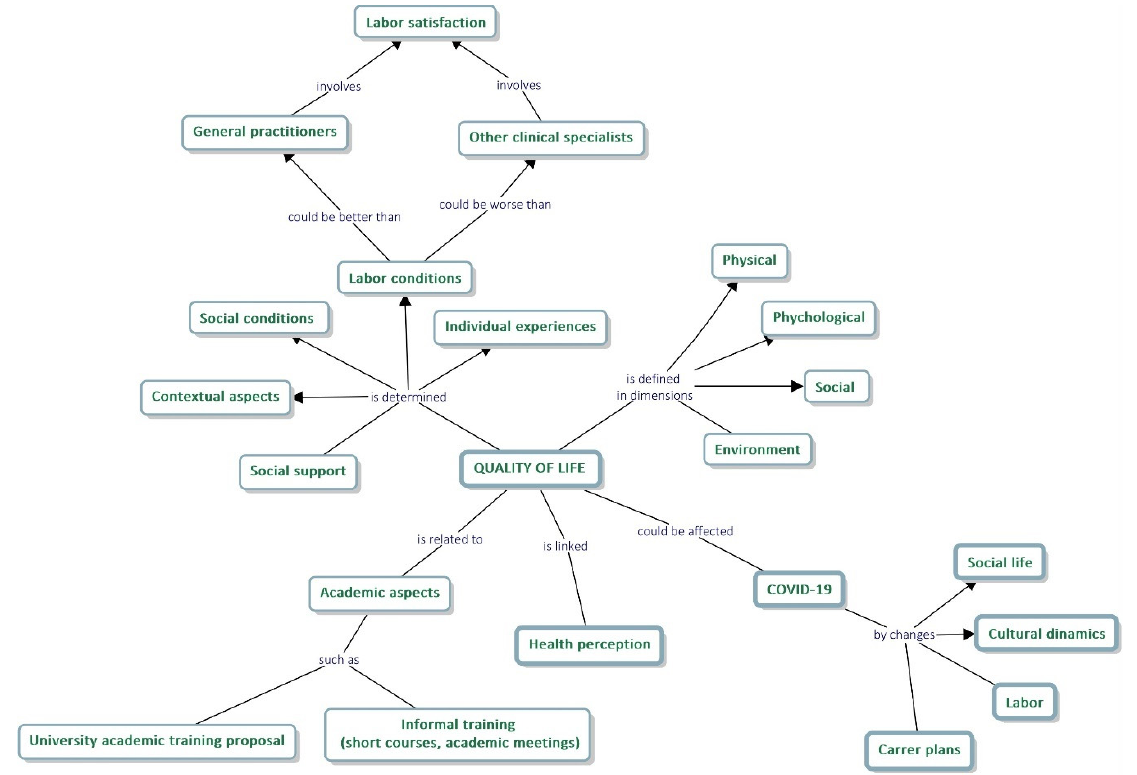
Figure 2. A conceptual explanatory map for understating the factors influencing QOL in the study population. Medellin, 2021–2022. Elaborated by using Cmaptools 6.03.01.